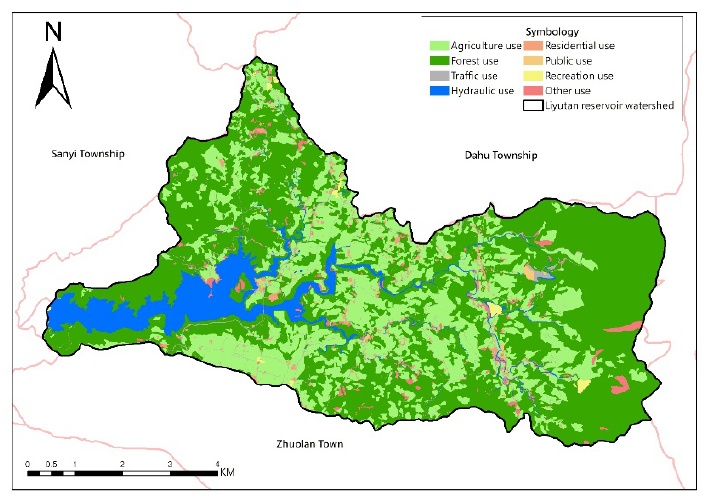
Figure 2. ( a ) Topographic map; ( b ) land-use distribution of the Liyutan reservoir watershed.